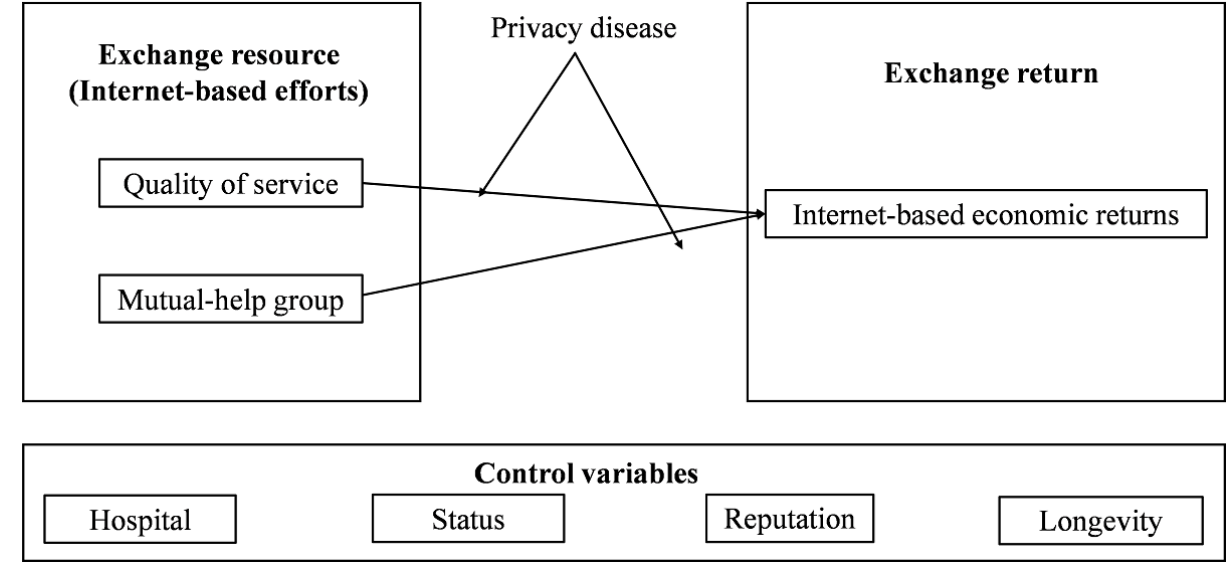
Figure 1. Exchange model describing doctors’efforts and